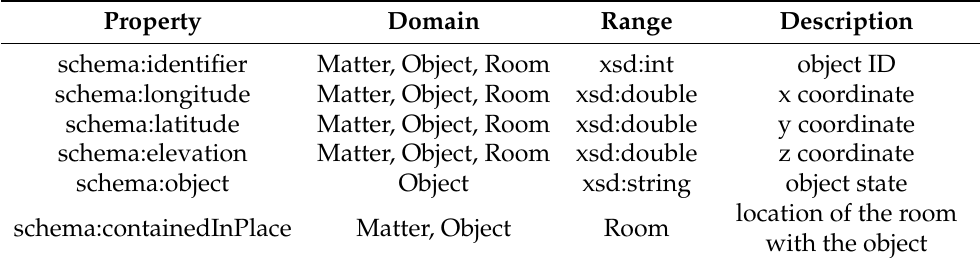
Table 2. Properties and their domains and ranges.